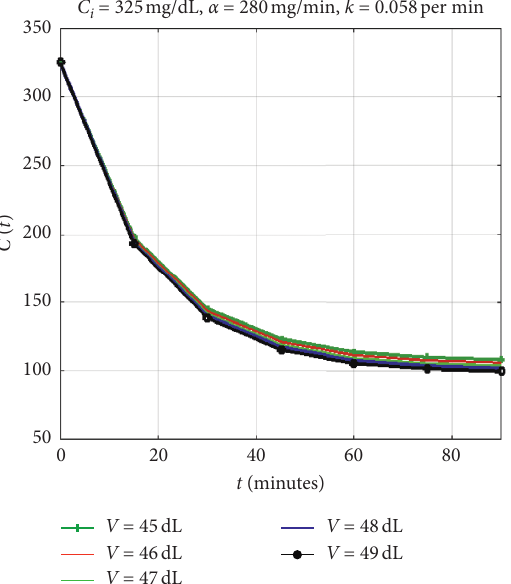
Figure 4: Blood glucose concentration C ( t ) for different values of constant velocity of elimination k and time t with V � 45 dL ,a � 280mg/min , and C � i